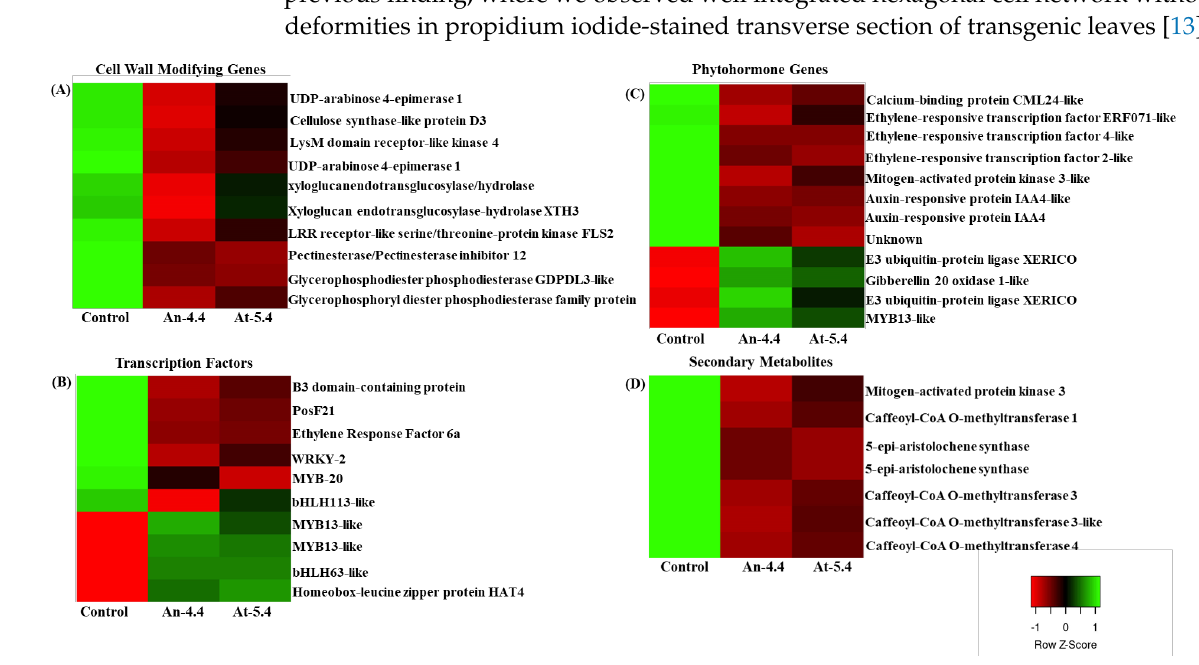
Figure 5. Expression analysis of cell-wall-related genes ( A ), transcription factors ( B ), phytohormone signaling genes ( C ), and secondary metabolite pathway genes ( D ) in control as well as in both (An-4.4 and At-5.4) transgenic lines.